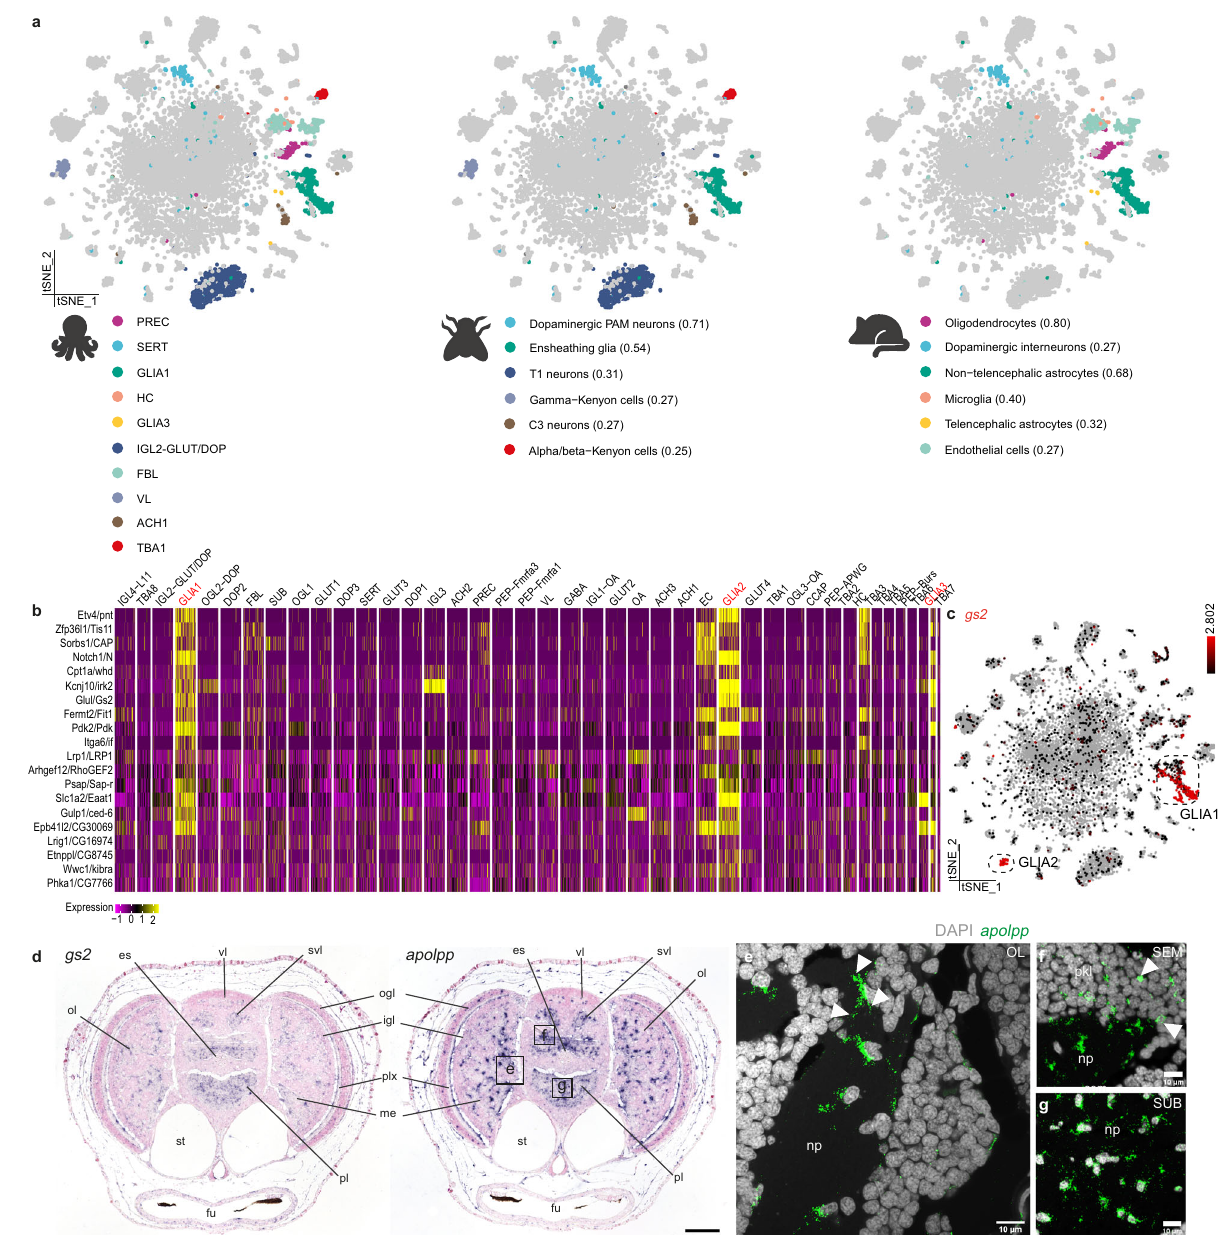
Fig. 4 | Cross-species cell-type comparisons identify a glial gene expression signature.a Cell-typemappings betweenoctopus, fl y, and mouse are represented on the t-SNE plot. Mappings are color-coded and alignment scores are shown between brackets. b Best reciprocal blast hits from the mapping between octopus GLIA1, fl y ensheathing glia, and non-telencephalic astrocytes in the mouse brain. Glial populations are highlighted in red. c t-SNE representation of two main glial populations in octopus based on the expression of gs2 (Glutamine synthetase 2). d In situ hybridization of gs2 and apolpp (Apolipoprotein). Scale bar represents